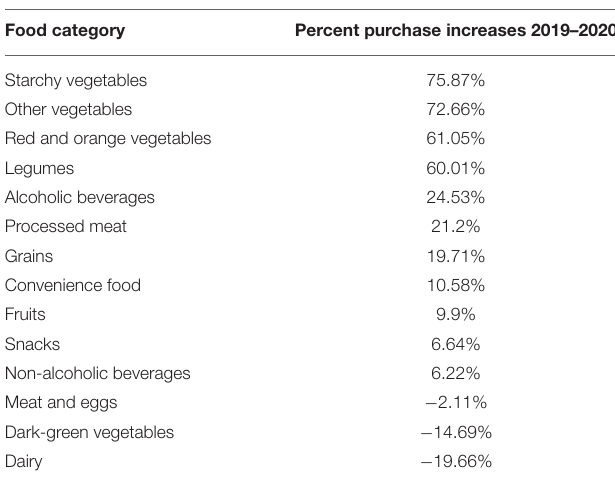
TABLE 5 | Percent increases in caloric value of customer food purchases per food category (in Kcal), comparing average monthly purchases in March and